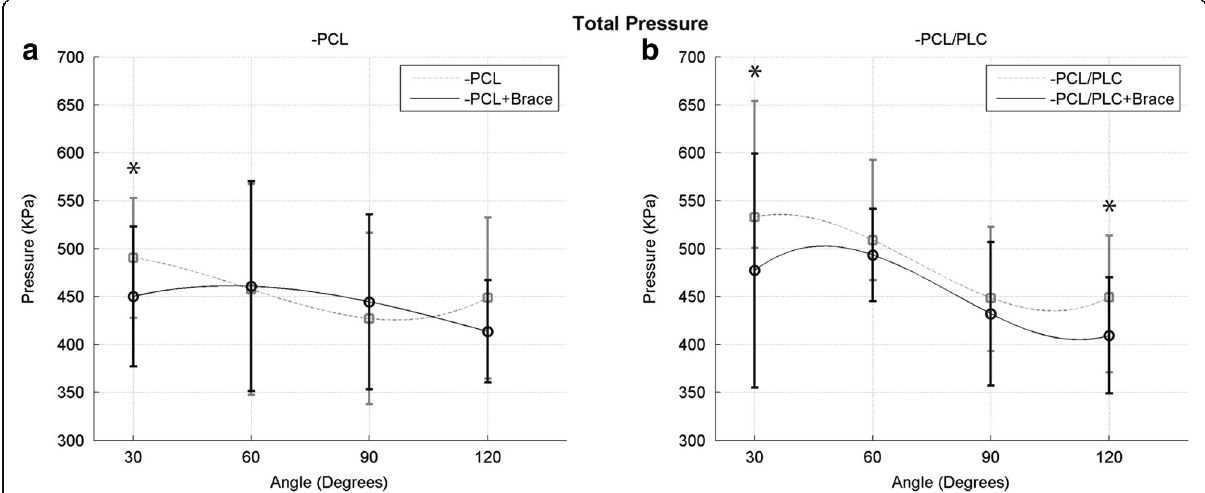
Fig. 3 Total pressure in the PFJ as a function of knee flexion angle in the PCL-deficient state ( a ) and PCL/PLC-deficient state ( b ) with and without the use of a dynamic brace (*indicates p < 0.05)